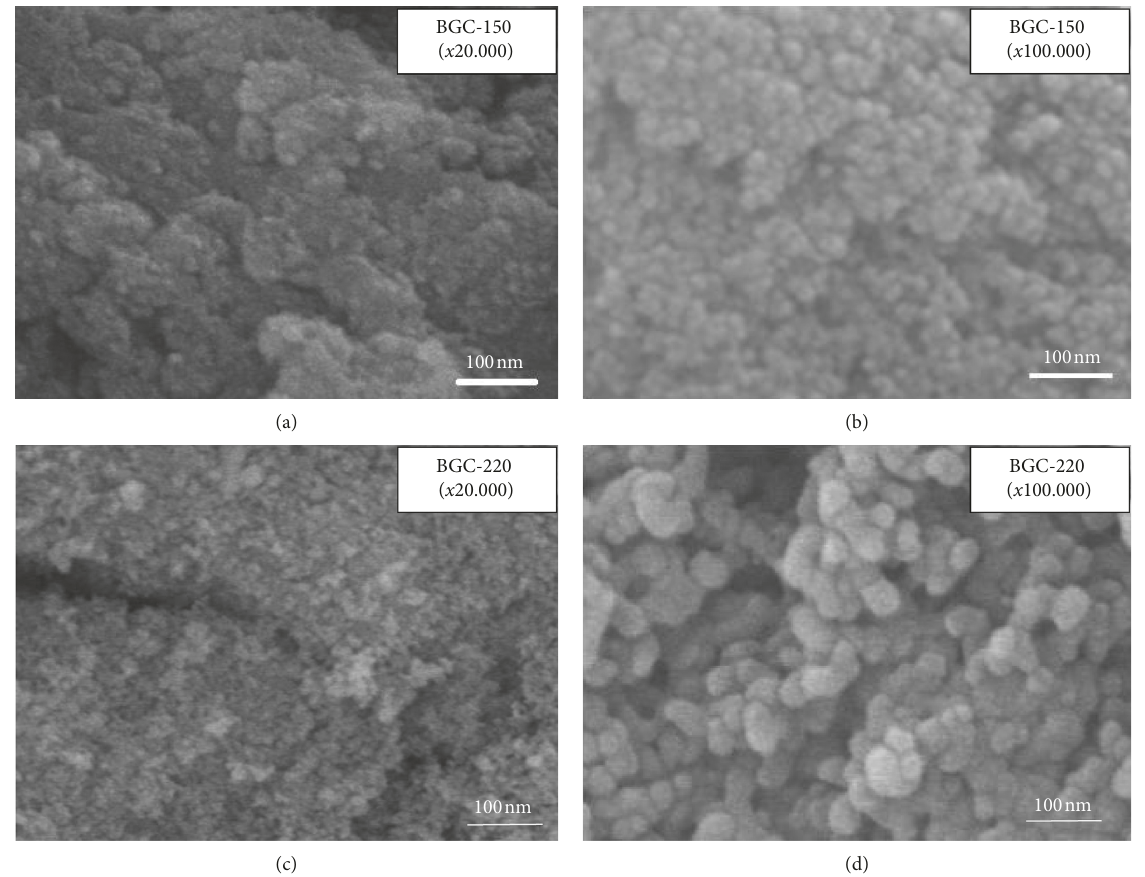
Figure 3: FE-SEM micrographs of BGC-150 and BGC-220 samples at different